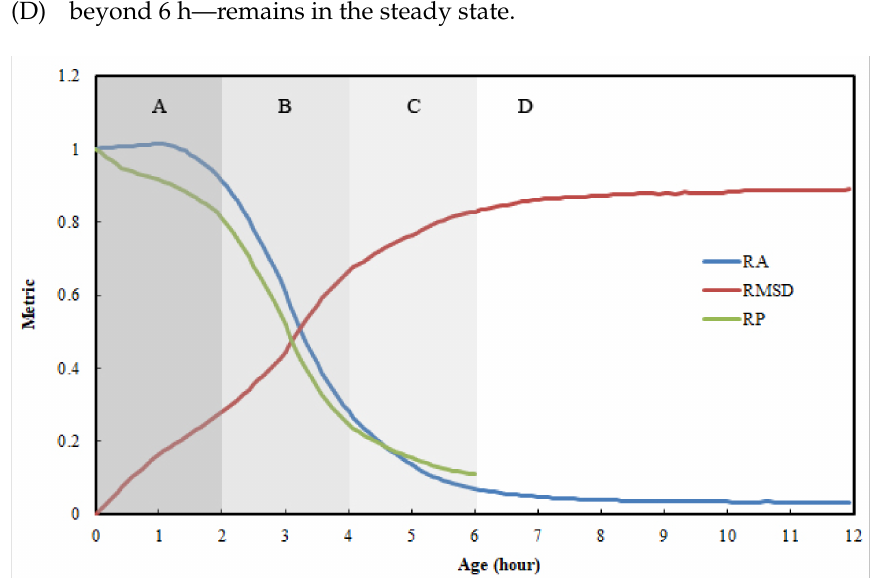
Figure 6. Metric as a function of material